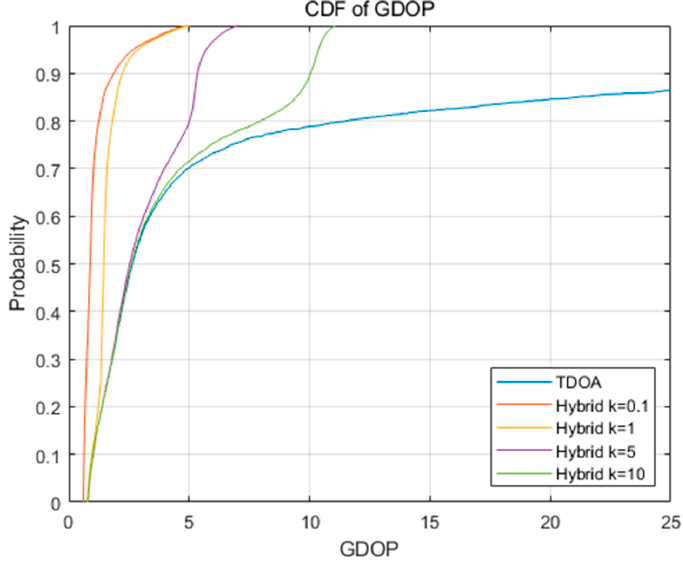
Figure 7. The cumulative distribution function (CDF) of different positioning methods GDOPs at all selected points. selected points.